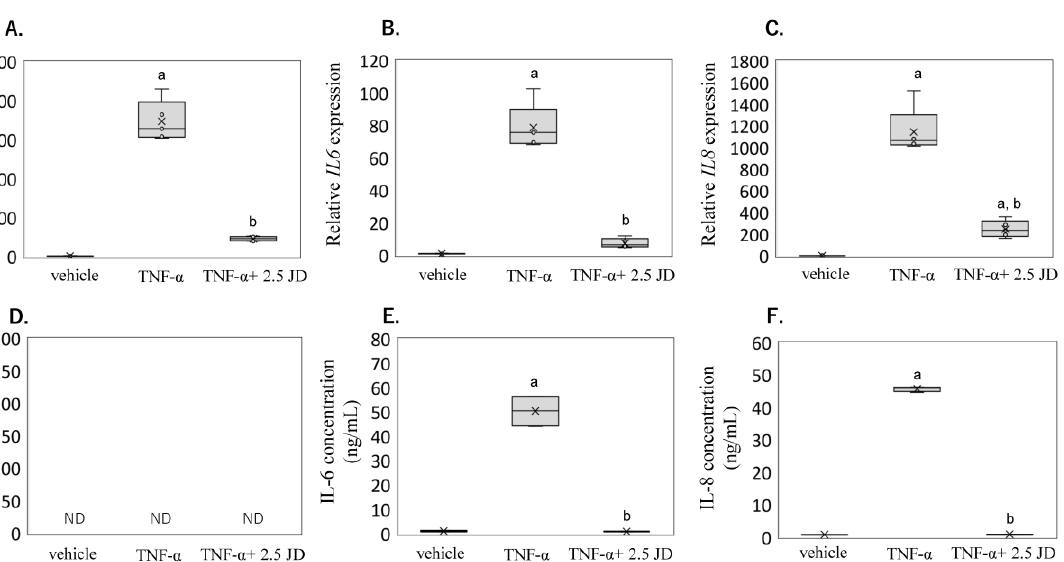
Figure 2. Effect of jietacin derivative on inflammatory cytokine expression and production in SW982. IL1B mRNA by qPCR ( A ) and IL- 1β protein concentration by ELISA ( B ). IL6 mRNA by qPCR ( C ) and IL-6 protein concentration by ELISA ( D ). IL8 mRNA by qPCR ( E ) and IL-8 protein concen- tration by ELISA ( F ). Synovial cell line SW982 stimulated with DMEM (vehicle), TNF- α, or TNF - α + jietacin derivative. a p < 0.05 compared to vehicle, b p < 0.05 compared to TNF- α .